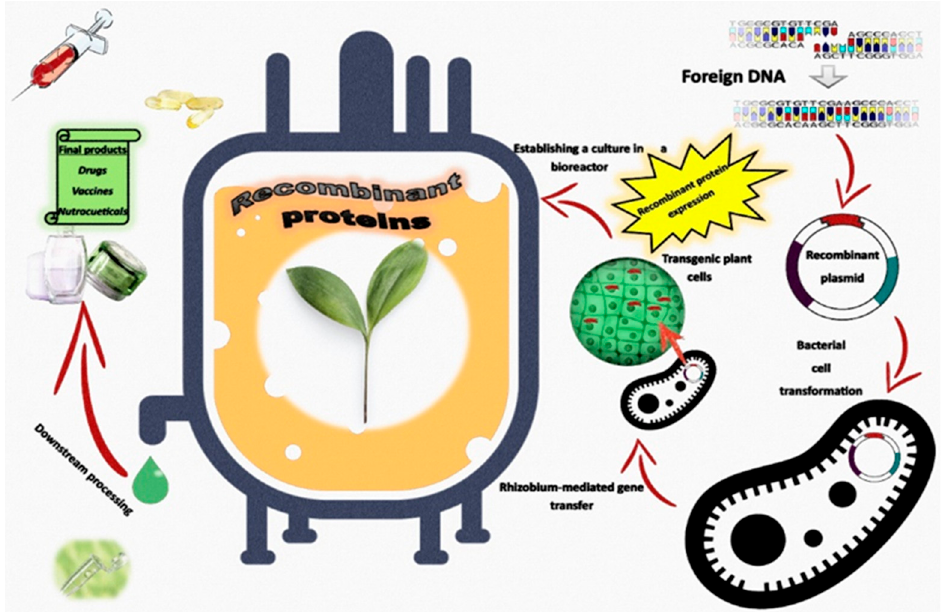
Figure 4. General strategy for the use of in vitro plant cultures in bioreactors for the production of recombinant proteins on an industrial scale.